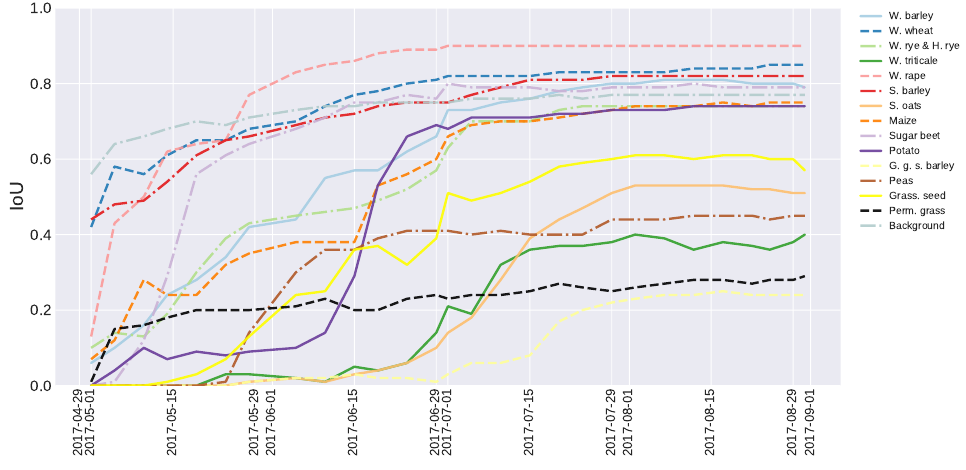
Figure 9. The IoU index at di ff erent dates.